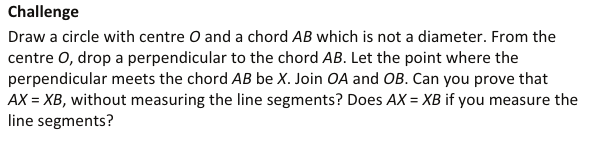
Challenge4.3 Chord proper(cid:16)es of a circle